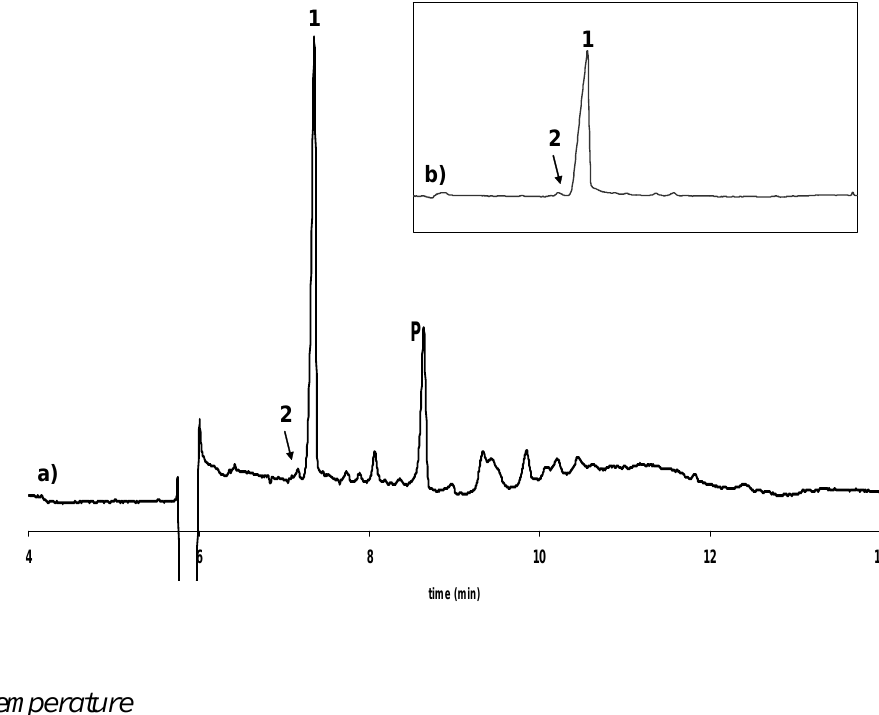
Figure 2. Electropherogram showing the enantioselective separation of catechin and epicatechin in a) an extract of unfermented, dried, unroasted cocoa beans and b) isolated from this extract. 1: (-)-Epicatechin, 2: (+)-Catechin, P: Procyanidin B2. Experimental conditions: uncoated fused-silica capillary [60 cm (effective length 50 cm) × 75 µm I.D.]; electrolyte: 0.1 mol·L -1 borate buffer, pH 8.5; chiral selector: 12.0 mmol·L -1 HP- γ -CD; voltage: 18 kV; UV-Detection: 280 nm; temperature: 20 °C; injection: pressure, 3 s, 0.3